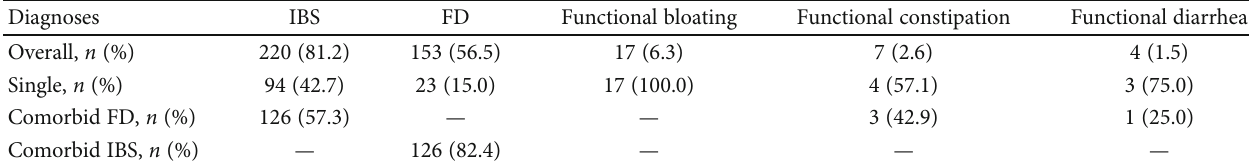
Table 1: Distribution of diagnostic overlap between the di ff erent